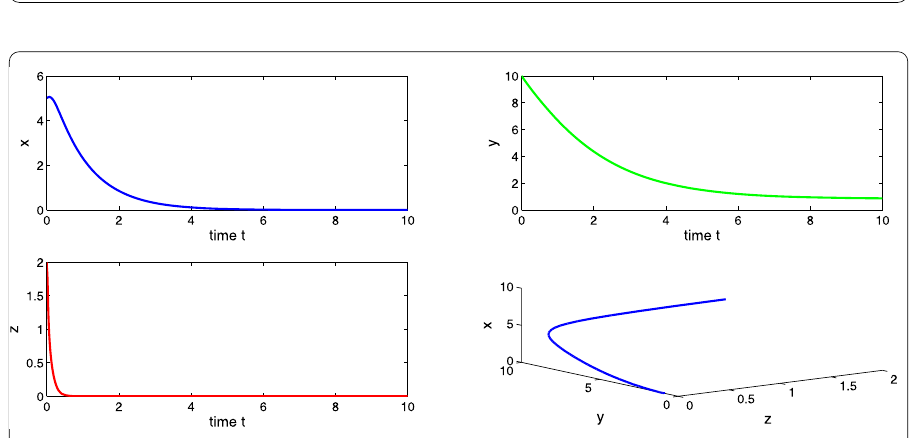
Figure 16 Time evaluation curve and three-dimensional phase portrait of the system for the parameter values a 1 = 0.3, a 2 = 0.6, a 3 = 0.5, a 4 = 0.7, (cid:5) = 0.05